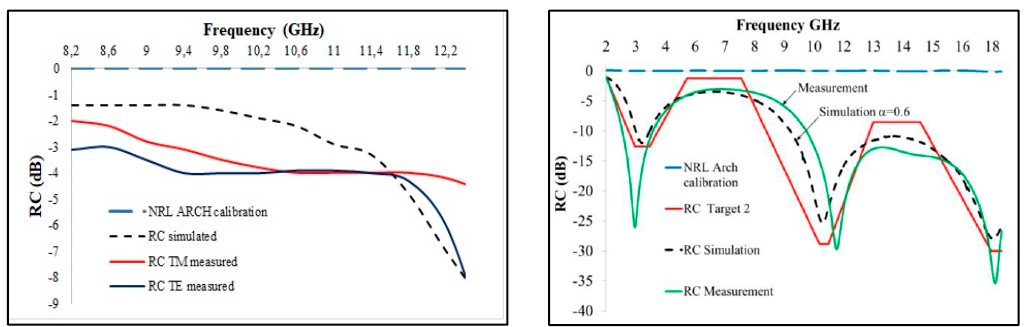
Figure 4. Results of reflection coefficient for Panel 1 (left) and Panel 2 (right) by free space characterization. NRL = Naval Research Lab. (RC = Reflection Coefficient; TM = Transverse Magnetic; TE = Transverse Electric)